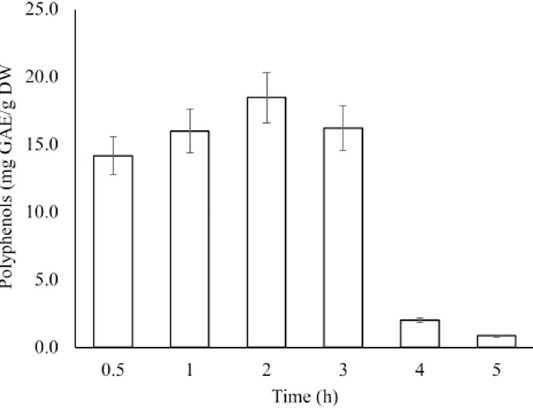
Fig 2. Effect of contact time on the extraction of total polyphenols from fruits of A . esculentus .